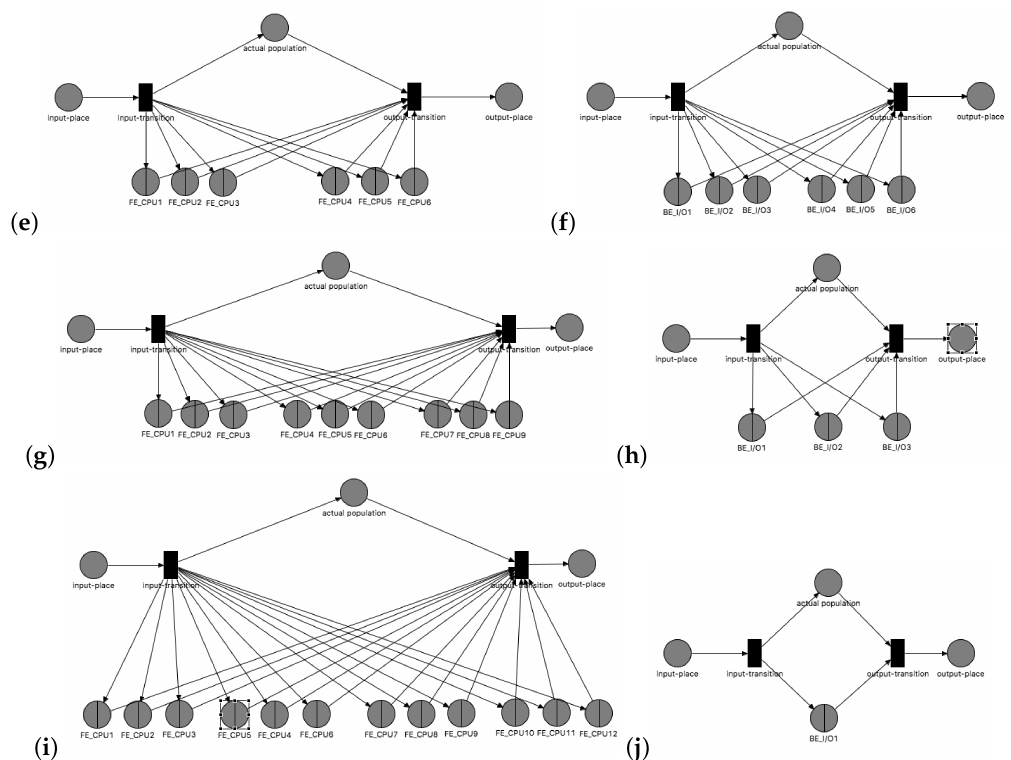
Figure 3. Sub-FE and Sub-BE pages modeling overview: ( a ) FE 1, ( b ) BE 12, ( c ) FE 3, ( d ) BE 9, ( e ) FE 6, ( f ) BE 6, ( g ) FE 9, ( h ) BE 3, ( i ) FE 12, ( j ) BE 1.